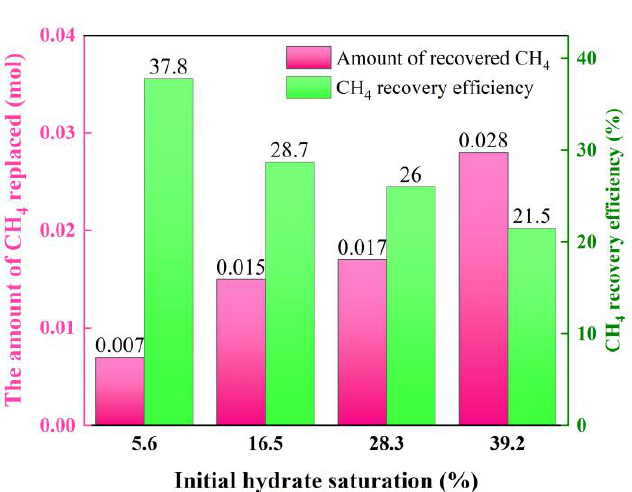
Figure 12. The recovery efficiency and replacement amount of CH 4 for Experiments 5, 6, 7, and 8.